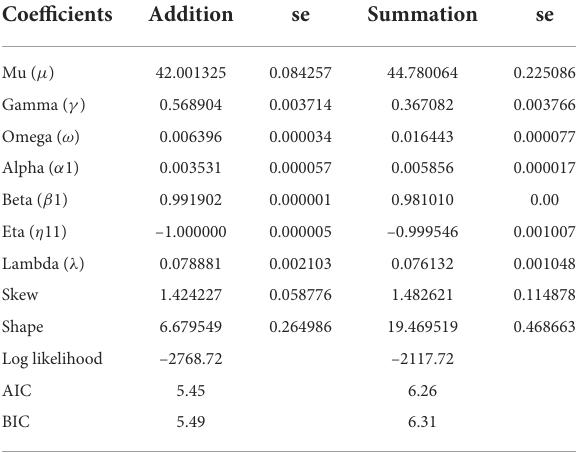
TABLE 4 Generalized autoregressive conditional heteroscedasticity model coefficients for mental arithmetic addition and summation tasks for the return study